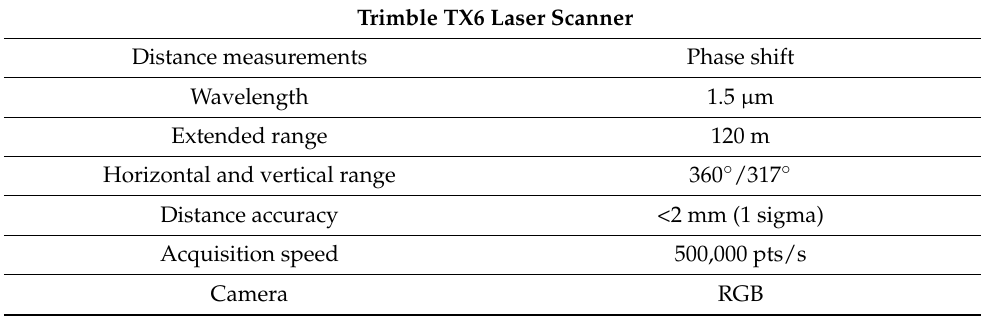
Table 4. Specifications of the Trimble TX6 terrestrial laser scanner.